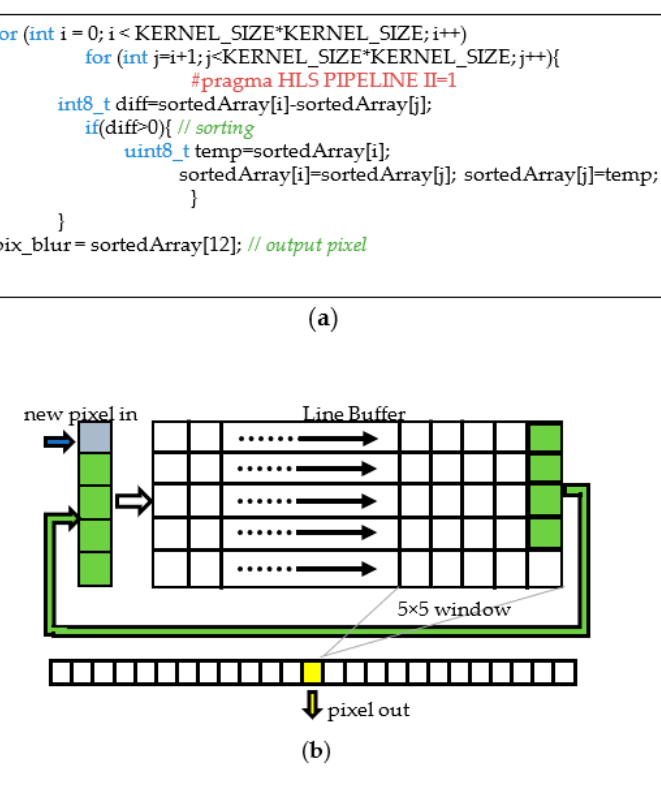
Figure 12. The design of the median blur hardware module: ( a ) excerpt of the C++ HLS code; ( b ) the resulting synthetized circuit architecture.